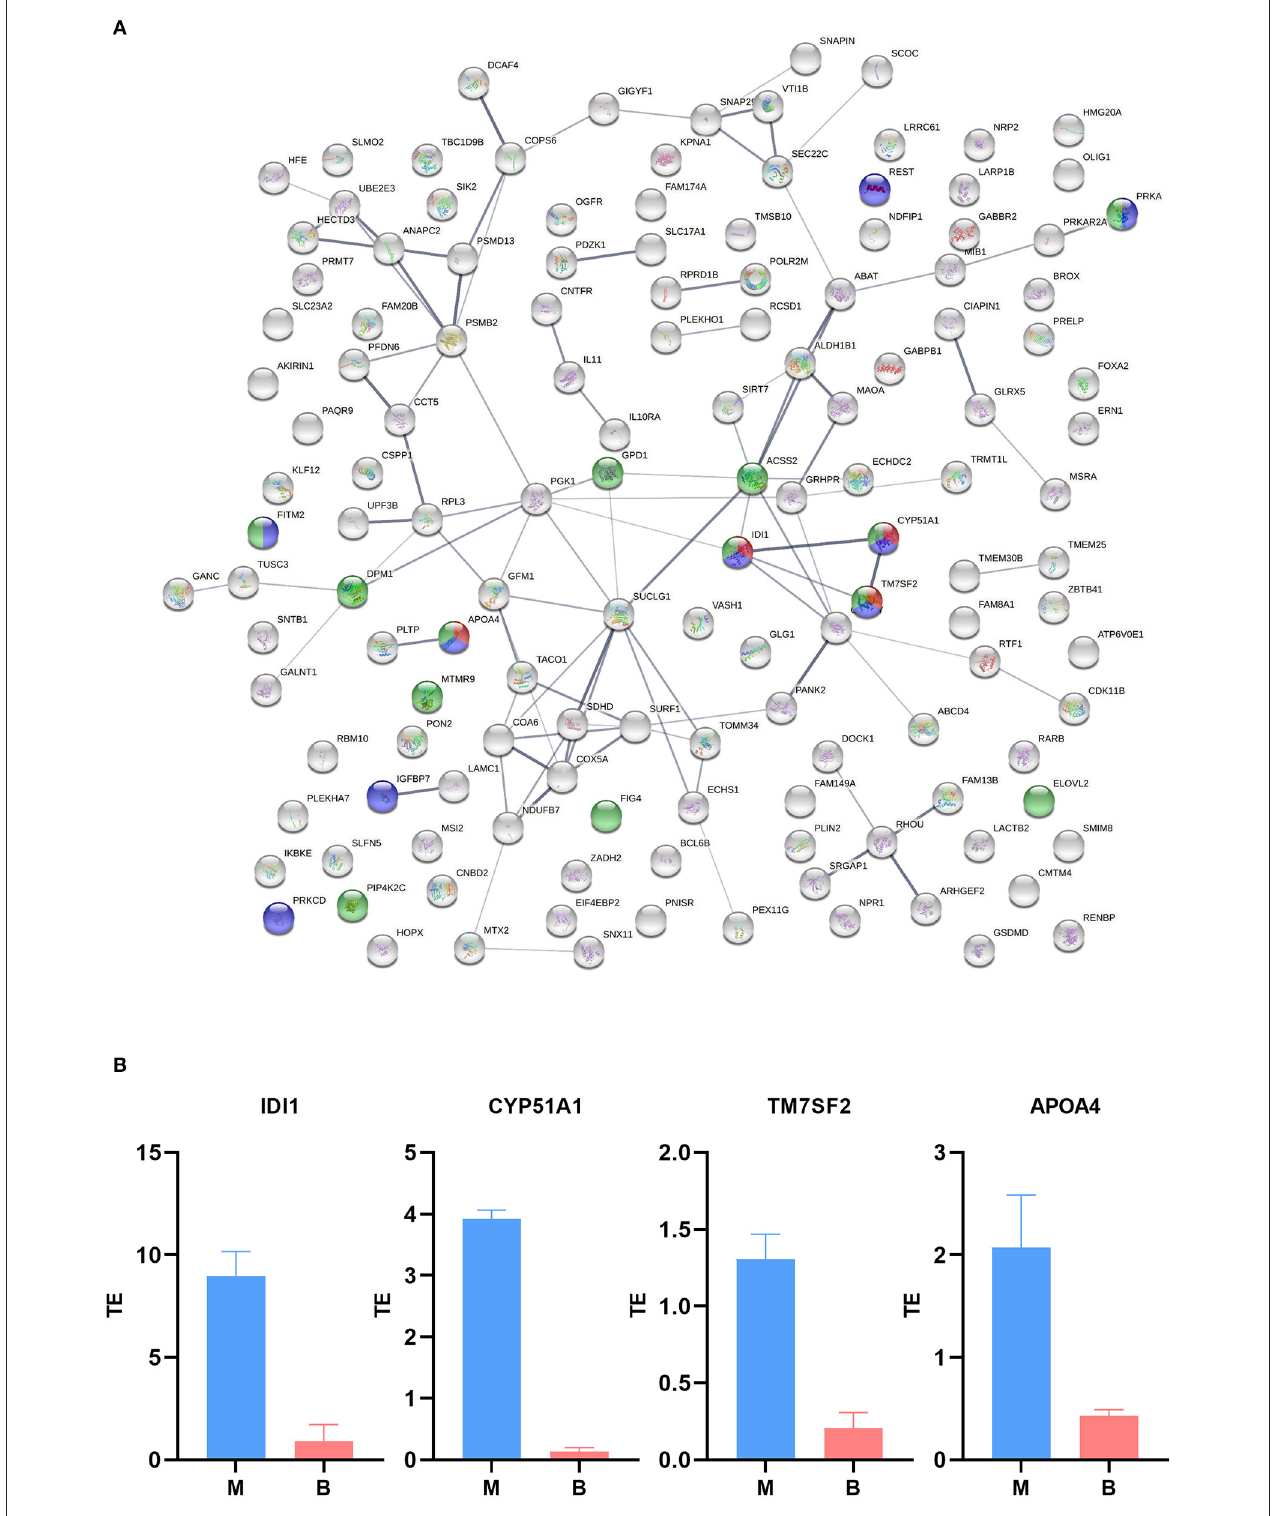
FIGURE 6 | Translation efficiency analysis. (A) Interactive and enriched map encoded by DTEGs. Green, lipid biosynthetic processes; purple, regulation of lipid biosynthetic processes; Red, cholesterol biosynthetic processes. (B) TE of key functional genes.